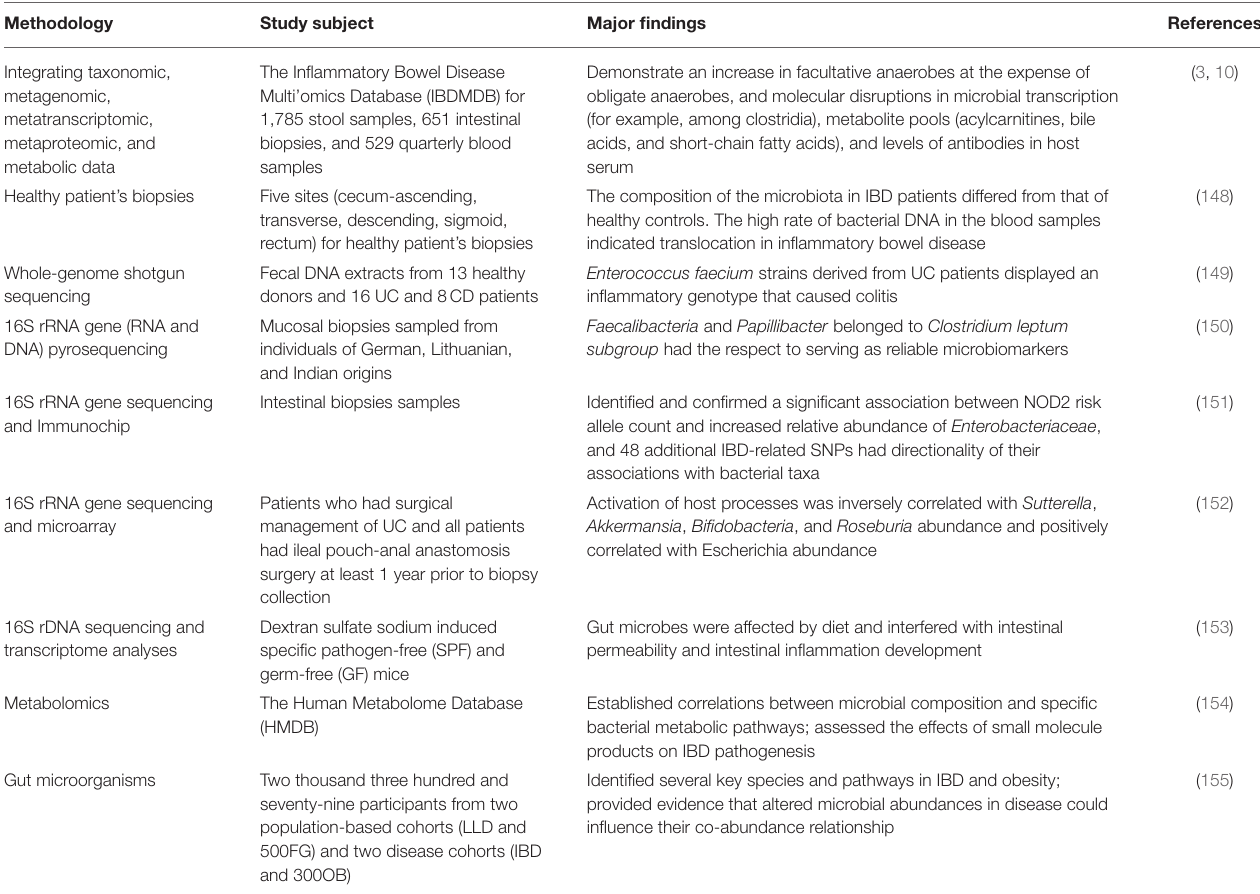
TABLE 3 | The correlation between gut microbe and IBD in some research with various